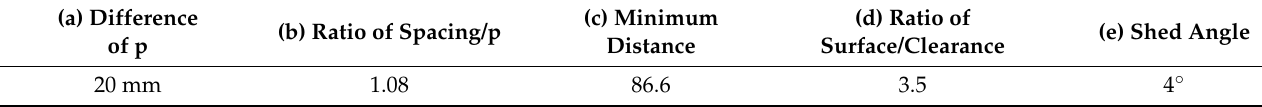
Table 5. Parameter of the shed